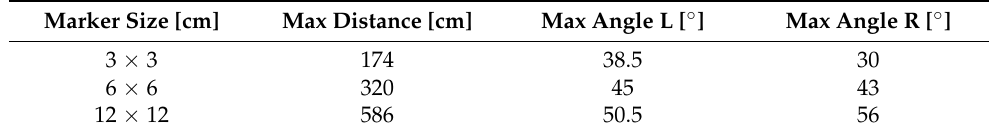
Figure 3. The marker identification rate versus distance. Table 1. Measurement results at 770 lx light intensity. Table 1. Measurement results at 770 lx light intensity.